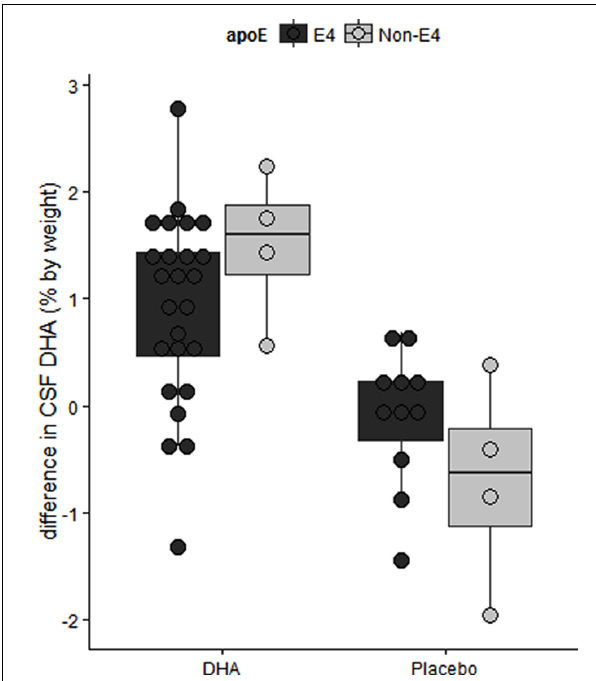
FIGURE 6 | The difference in CSF DHA levels by intervention arm in the ADCS sponsored DHA clinical trial. Older APOE4 carriers with mild AD had lower CSF DHA levels after 18 months of DHA supplementation. Adapted from Yassine et al.